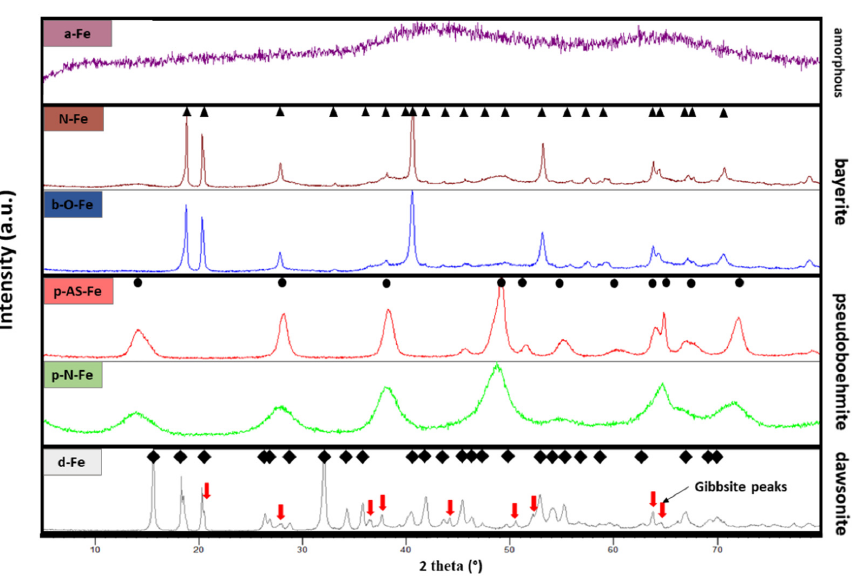
Figure 1. XRD patterns of synthesized iron-containing alumina precursors, indicating three distinct forms: bayerite ( ▲ ), pseudoboehmite ( ● ) and dawsonite ( ♦ ). Red arrows in the XRD patterns of sample »d« represent some additional detected peaks of gibbsite.